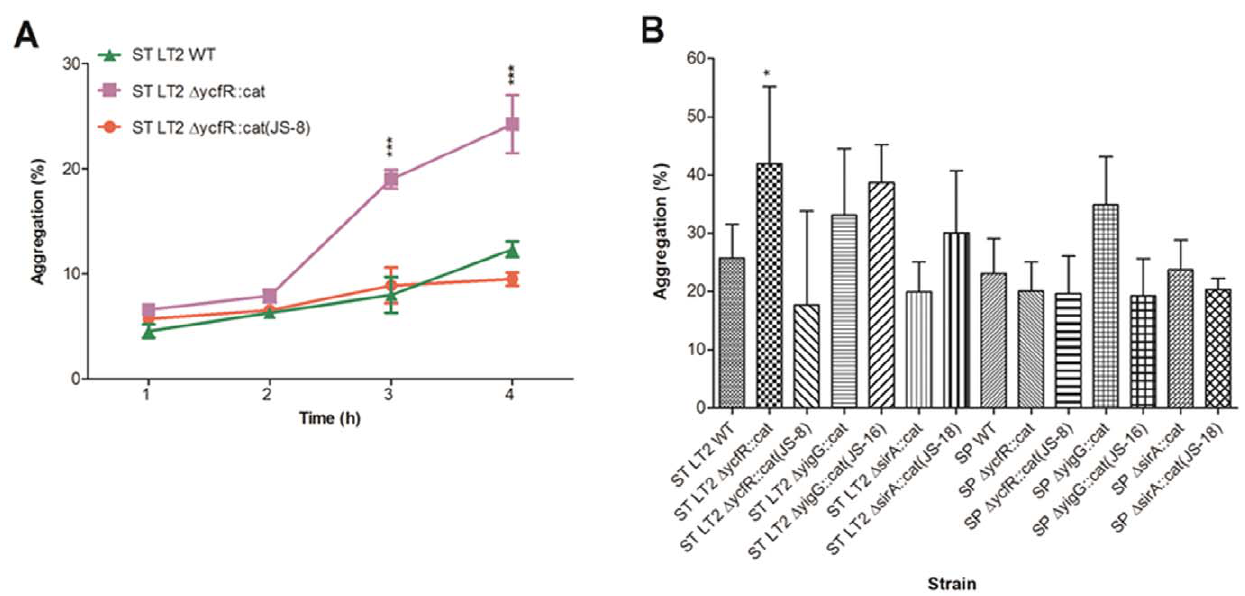
Figure 3. S.enterica aggregation assays. A) Aggregation of S. Typhimurium LT2 WT, D ycfR::cat mutant, and D ycfR::cat (JS-8) complement over 4 h. B) Aggregation of all S. enterica strains after 24 h incubation at room temperature. Standard deviations represent three independent experiments. Significant differences in comparison to the parent strains under the same condition are shown as *( P , 0.5), **( P , 0.001), and ***( P , 0.0001).